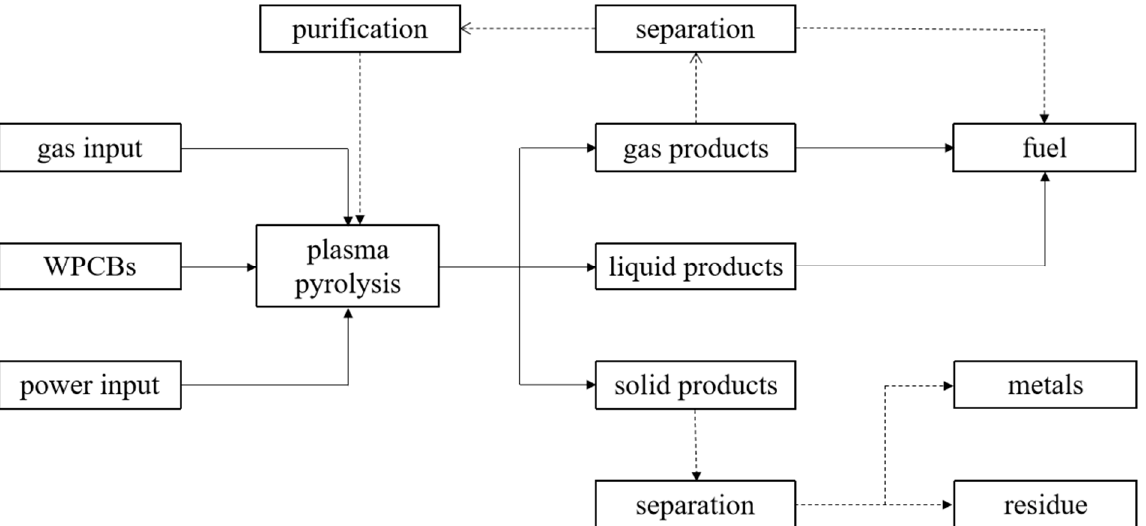
Figure 3. Scheme of the technological process in three-phase alternating arc plasma assisted utilization of WPCBs.